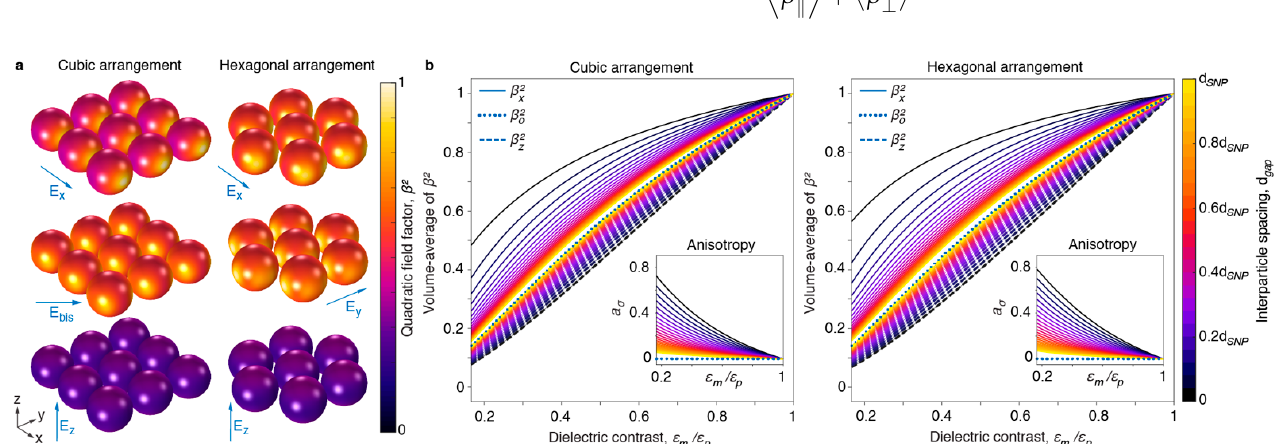
Figure 3. Simulated absorption properties of SNPs arranged in a monolayer. ( a ) Distribution of the quadratic field factor β 2 ( r ) for different arrangements of particles with the external field (blue arrow) perpendicular or parallel to the plane of the layer of SNPs, in the medium with ε m = 2.25 ε o ( n = 1.5 ). ( b ) Volume-average < β 2 > for SNPs arranged in a square (left) and triangular lattice (right) as a function of dielectric contrast ε m / ε p and interparticle spacing d gap . Inset graphs show the corresponding absorption anisotropy a σ .